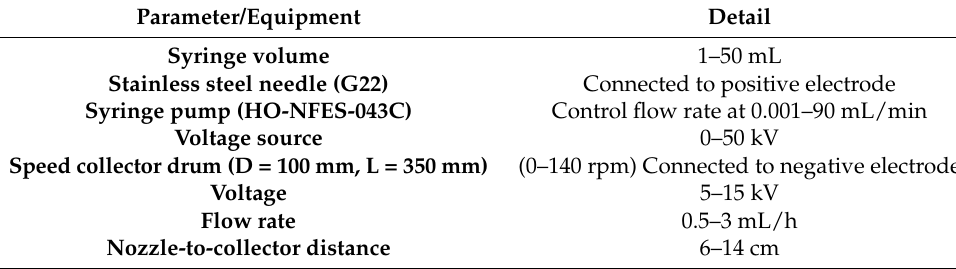
Table 2. Electrospinning parameters/equipment details.